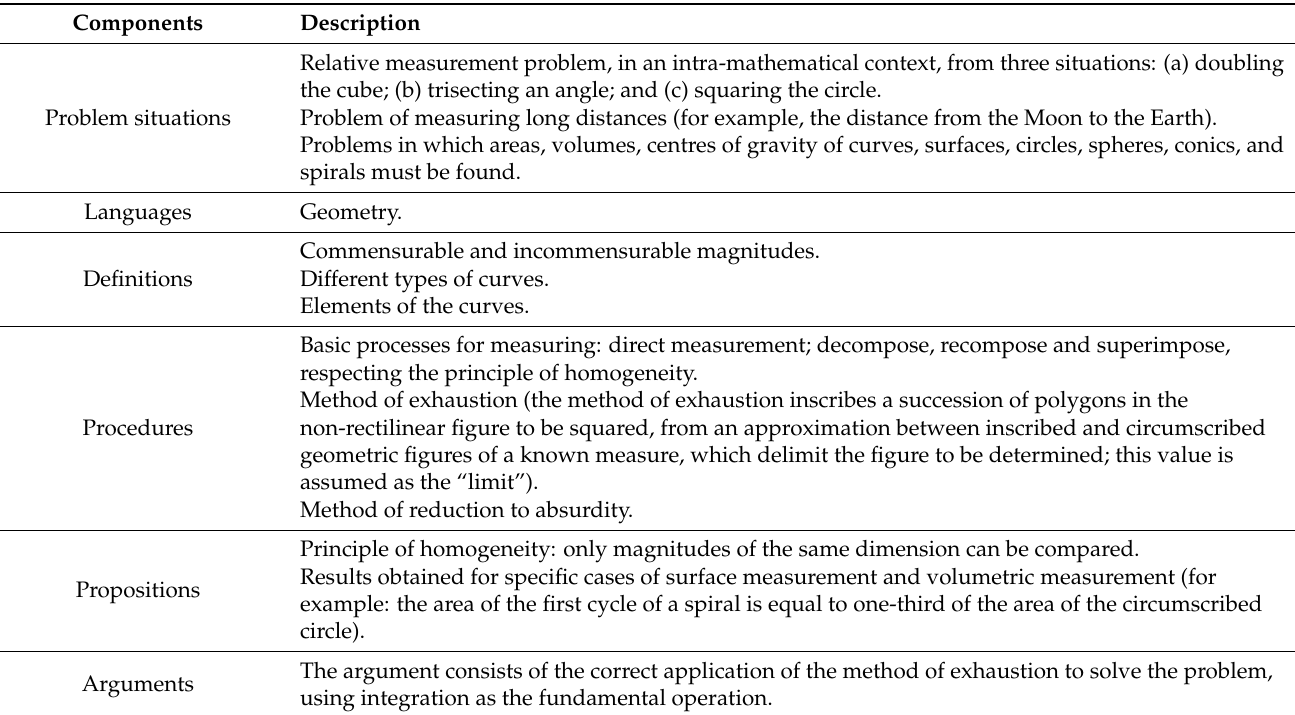
Table 2. GEC1. Origins of the